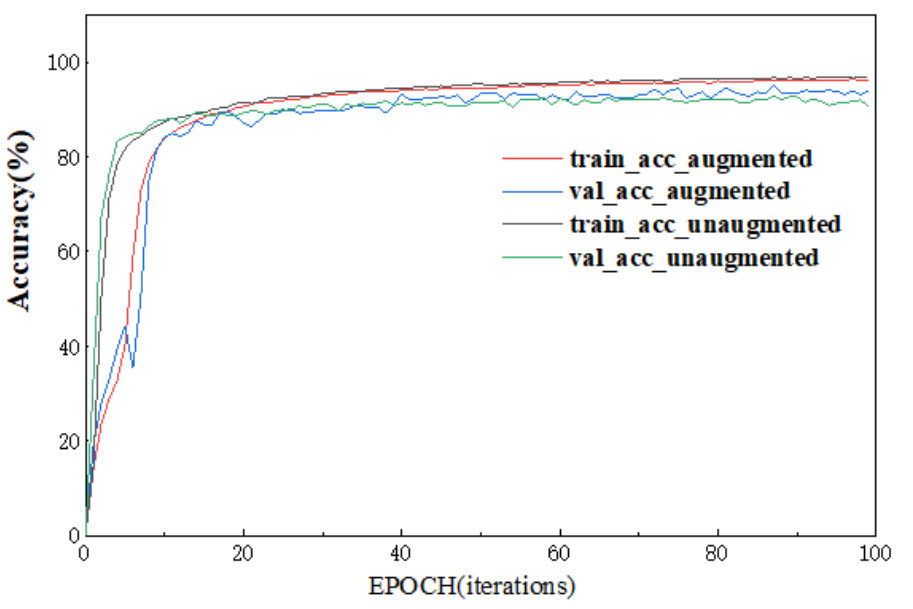
Figure 13. Train/validation accuracy on augmented/unaugmented dataset.